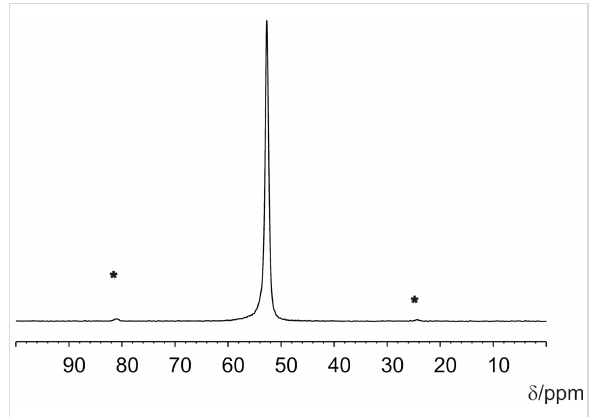
Figure 4: 19 F MAS NMR spectrum of MFU-4 (Sample 3b) loaded with SF 6 recorded at room temperature. The spectrum was referenced against CFCl 3 .